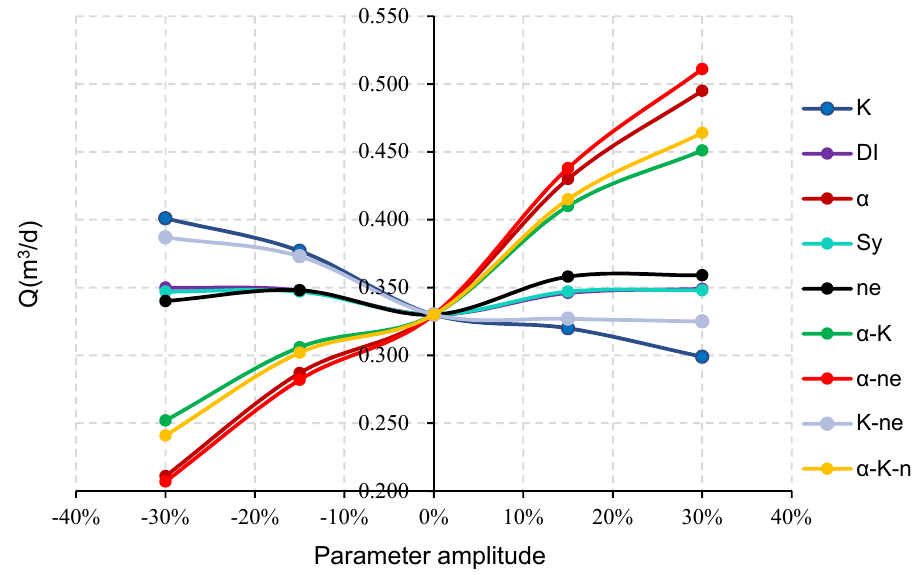
Figure 7. The variations of Q T for different parameter combinations.